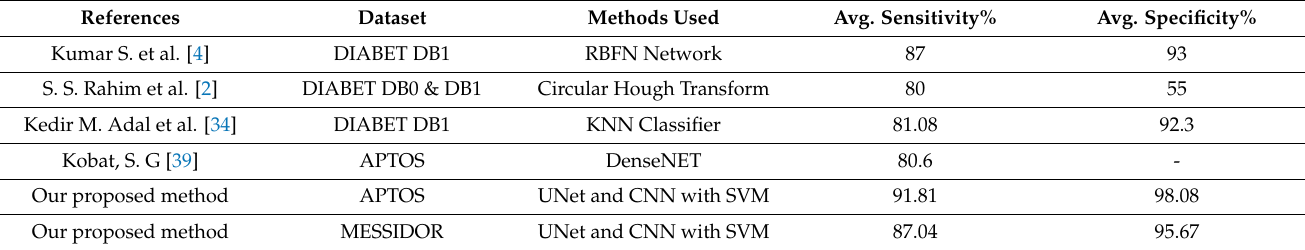
Table 3. Comparison of results of existing methods and the proposed method.